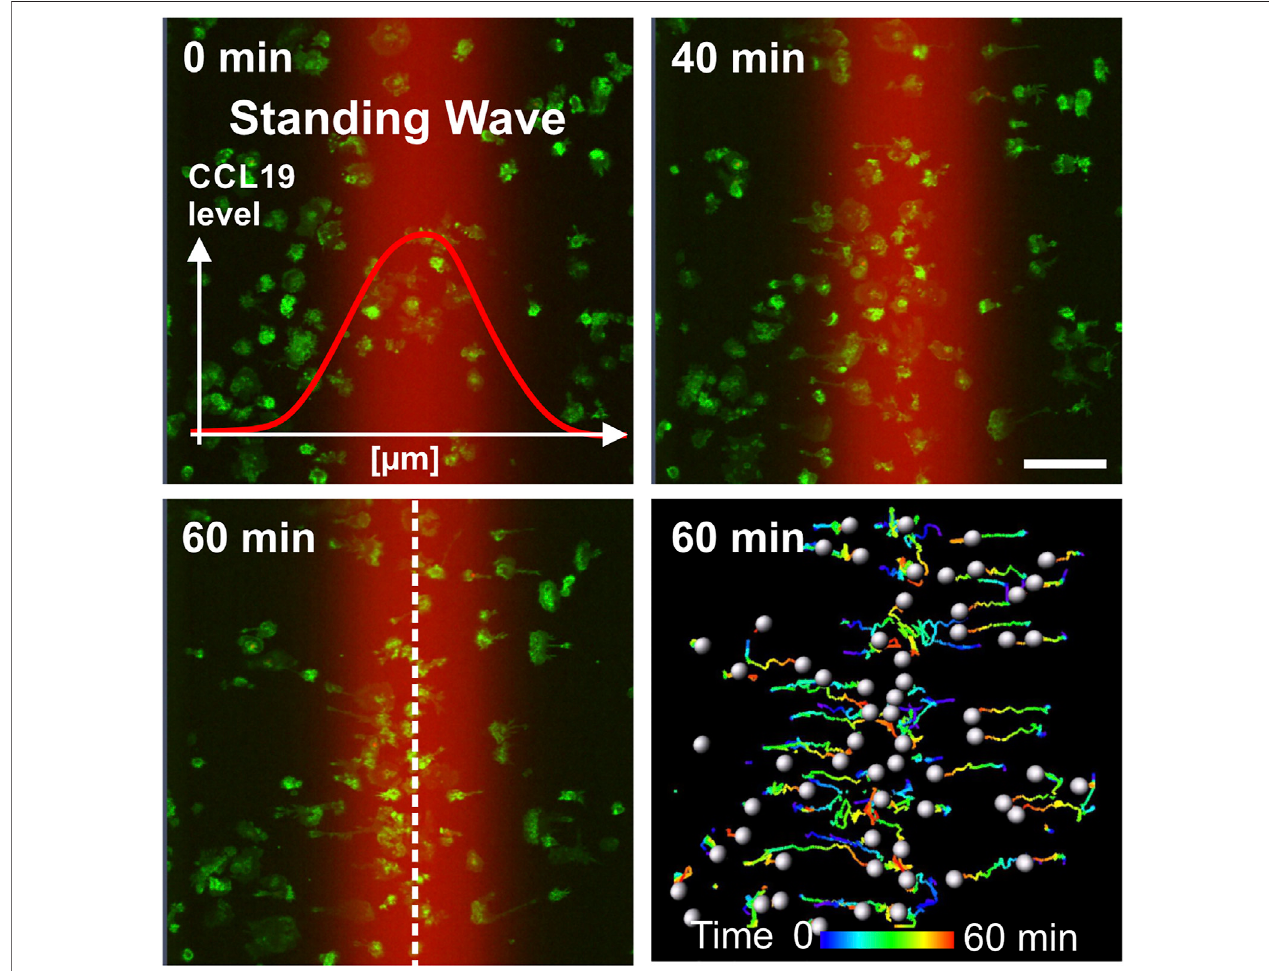
FIGURE 3 | Directional migration of BM-DCs towards single standing CCL19 waves. Analysis of BM-DCs migration towards both halves of a symmetric bell- shaped standingCCL19wave.TracksofindividualmotileLifeact-EGFPexpressingBM-DCsarepseudo-colored(timeiscolor-coded:blue=0 min,red=60 min).Peak region of the standing wave is indicated by white dashed line. Scale bar = 100 µm. See also Supplementary Video S2 .